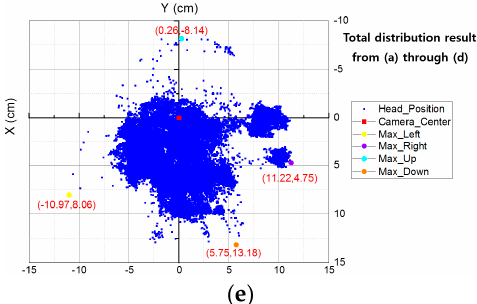
Figure 8. Subjects’ head movements on the x - and y -axes in 3D space when: ( a ) playing a game; ( b ) surfing the web; ( c ) typing; and ( d ) watching a movie. ( e ) Total distribution result that contains data from ( a ) to ( d ).